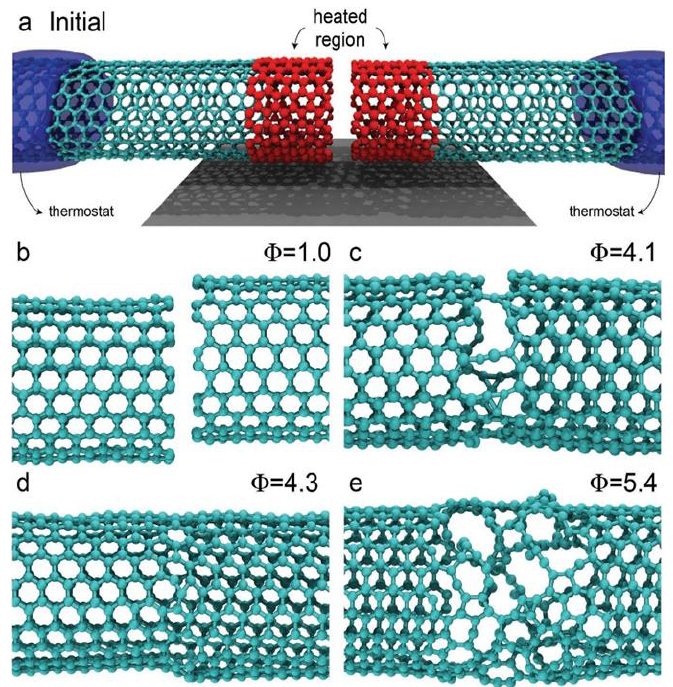
Figure 13. ( a ) Two CNTs are first arranged with their axes aligned at 180°. The atoms in red are heated from outside and are located at the contact tips of both tubes. ( b – e ). The tubes’ final configuration following heating with heat fluxes of 1.0, 4.1, 4.3, and 5.4 kcal mol −1 fs −1 , respectively. Reprinted with permission from Ref. [134]. Copyright © 2016, John Wiley and Sons.